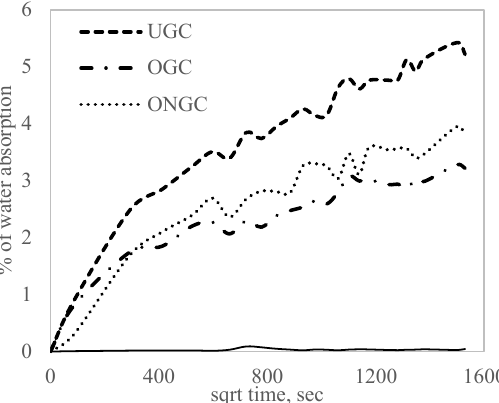
Figure 9. The water absorption proficiency percent mass gain for all the composites with 10% particle loading in comparison with HDPE (smooth line).